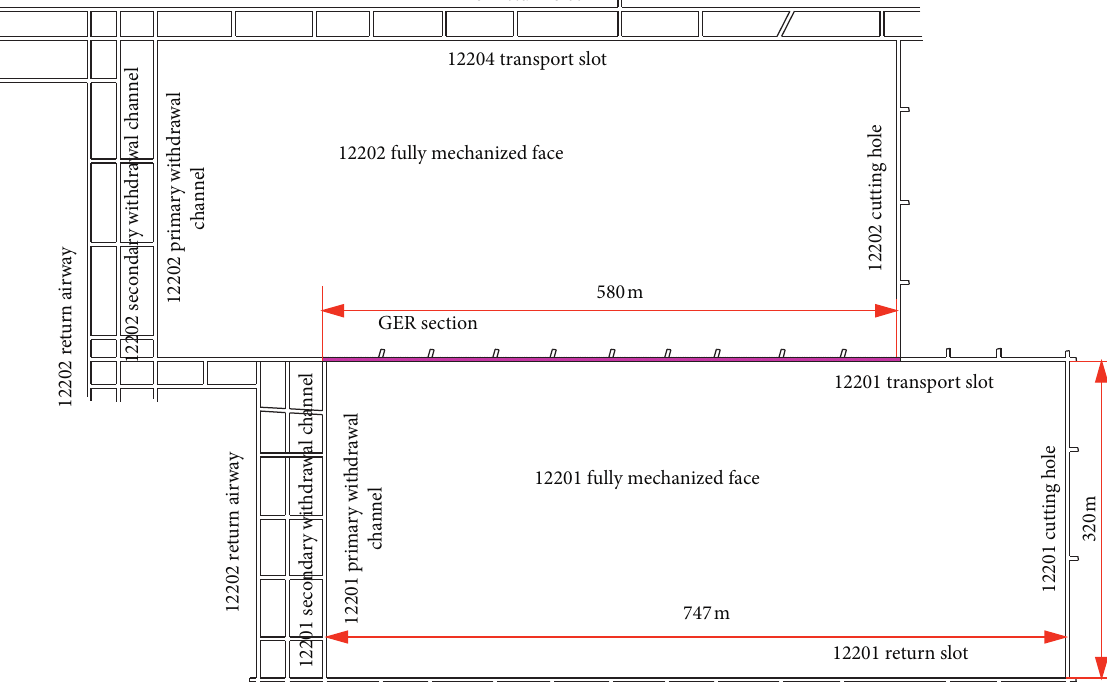
Figure 3: 12201 face layout.